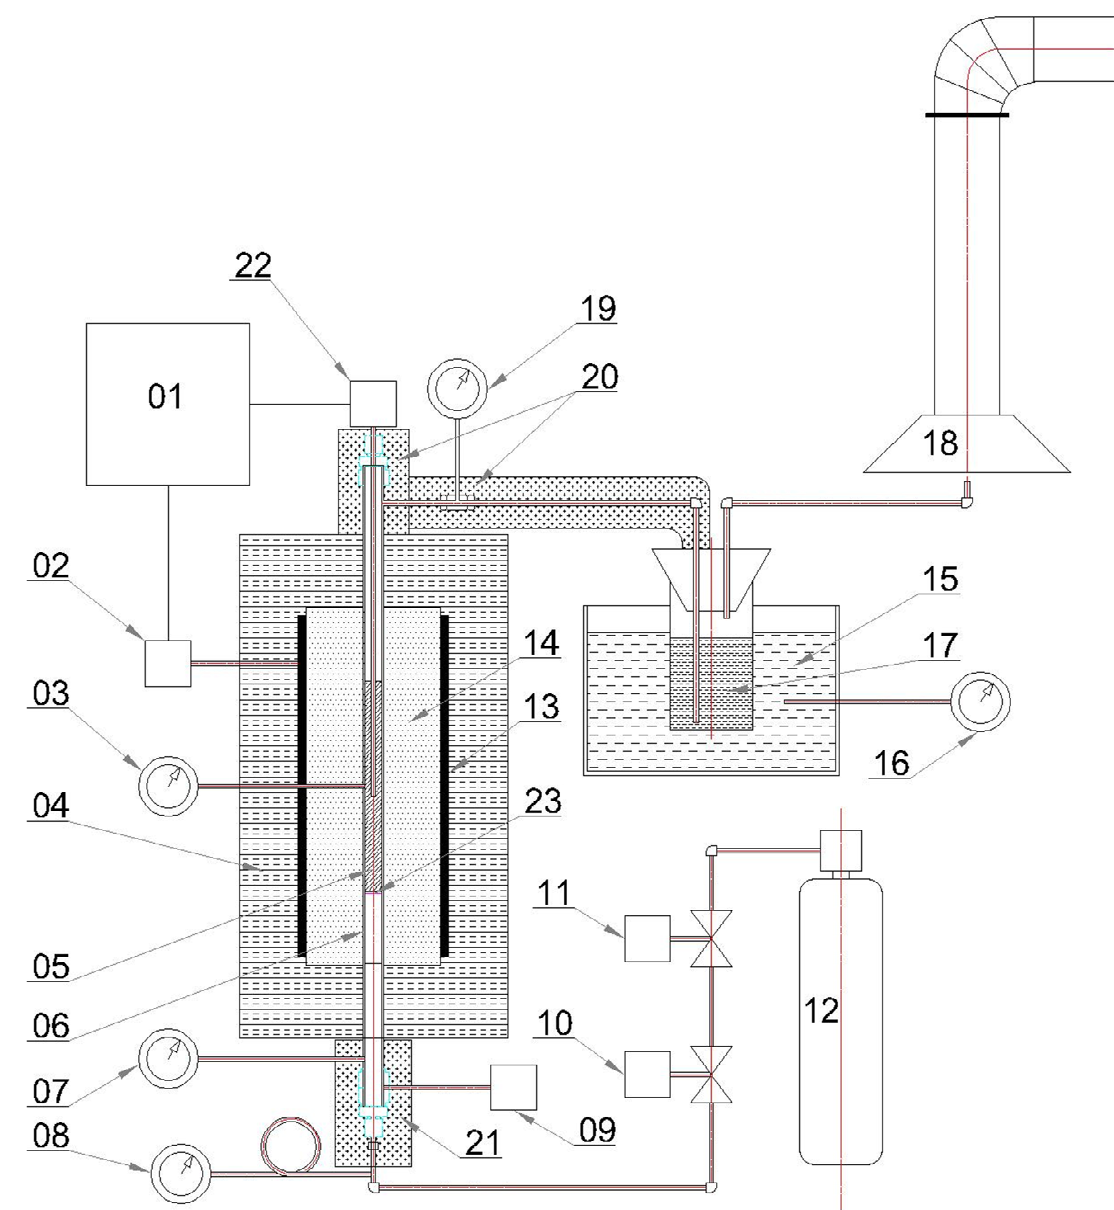
Figure 2. Schematic representation of the batch torrefaction unit (BTU), adapted from [30]. 1: Indi- cating temperature controller; 2: Temperature control element; 3, 7, 8, 16 and 19: Local temperature gauges; 4: Insulation; 5: Wood sample; 6: Tube reactor; 9: Time-base temperature controller; 10: Mass flow-rate controller; 11: Pressure regulator; 12: Nitrogen tank; 13: Conduction heaters; 14: Furnace heating zone; 15: Ice-NaCl bath; 17: Torrefaction liquor; 18: Fume hood; 20 and 21: Heating tape; 22: Thermocouple; 23: Porous metal distributor.